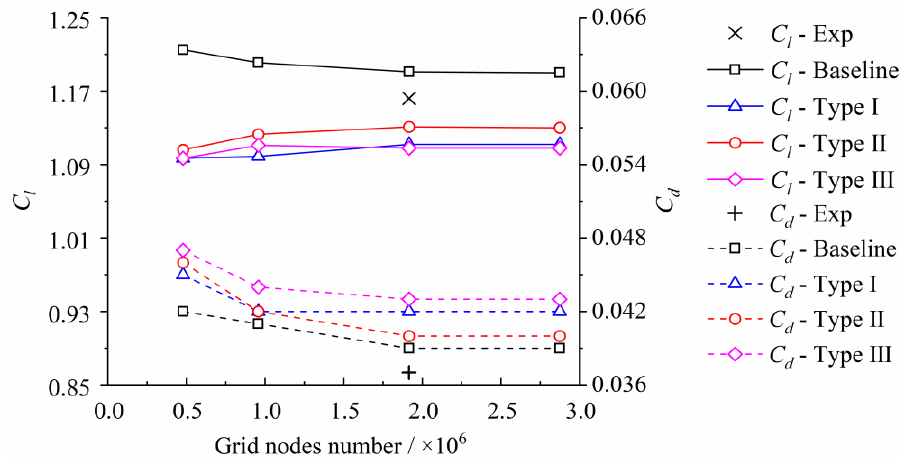
Figure 3. Grid dependency study for lift and drag coefficients under non-cavitation.